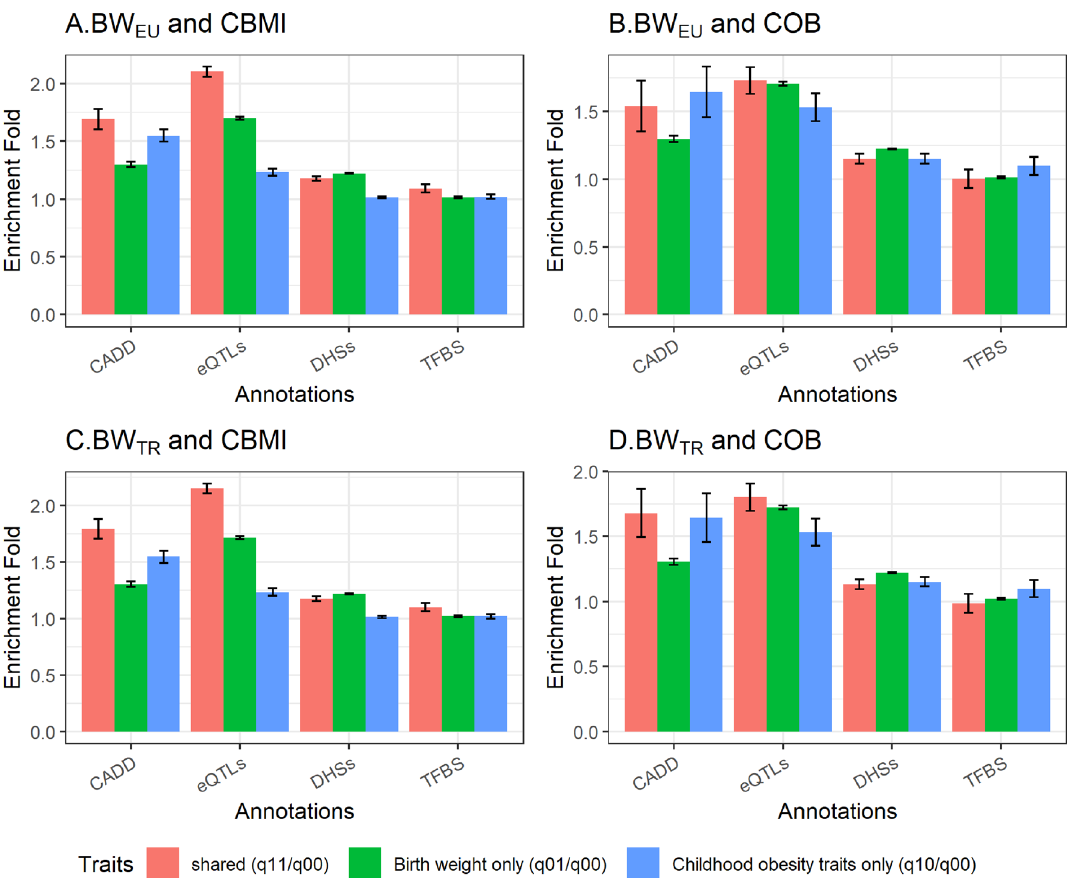
Figure 1. Enrichment of four functional annotations among loci jointly associated with birth weight and childhood obesity traits. ( A ) European birth weight and childhood body mass index (BW EU -CBMI), ( B ) European birth weight and childhood obesity (BW EU -COB), ( C ) Trans-ethnic birth weight and childhood body mass index (BW TR -CBMI), ( D ) Trans-ethnic birth weight and childhood obesity (BW TR -COB). The bars denote the enrichment fold for variants that are associated jointly with BW and childhood obesity traits (red), only with birth weight (green), and only with childhood obesity traits (blue),